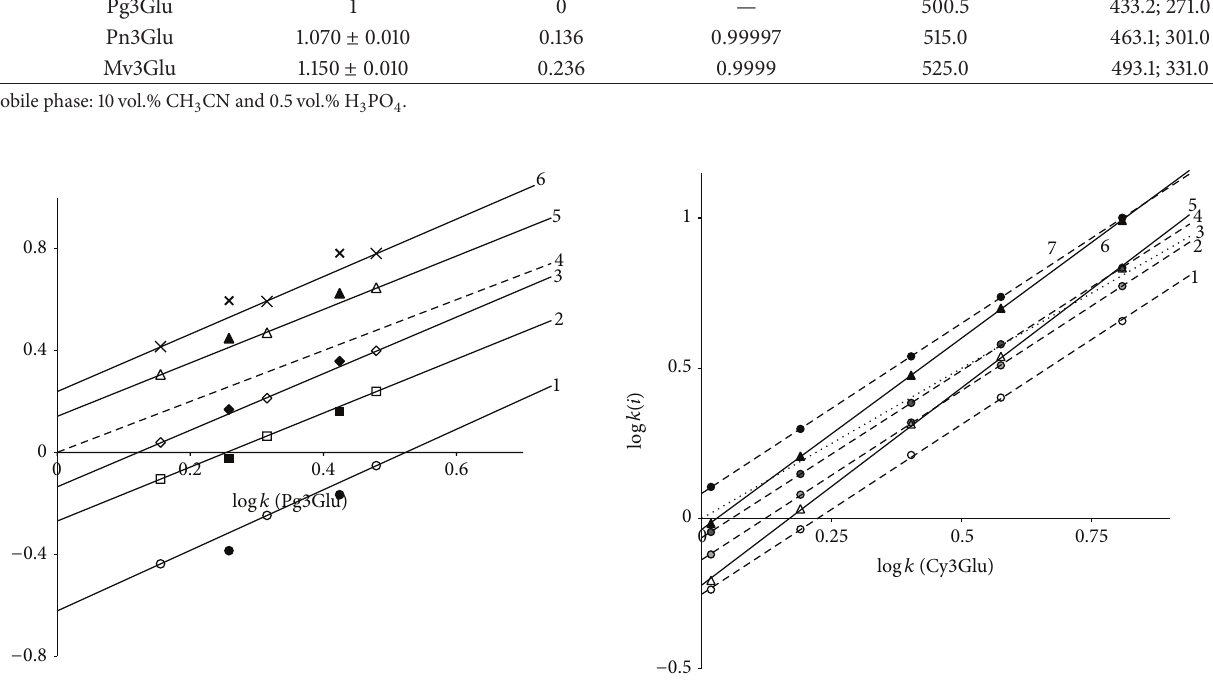
Figure 5: Comparison of separation maps for Dp3Glu (1); Cy3Glu (2); Pg3Glu (3); Pt3Glu (4); Pn3Glu (5); and Mv3Glu (6) in System 1 (empty markers with lines) and in System 2 (corresponding black markers without lines).